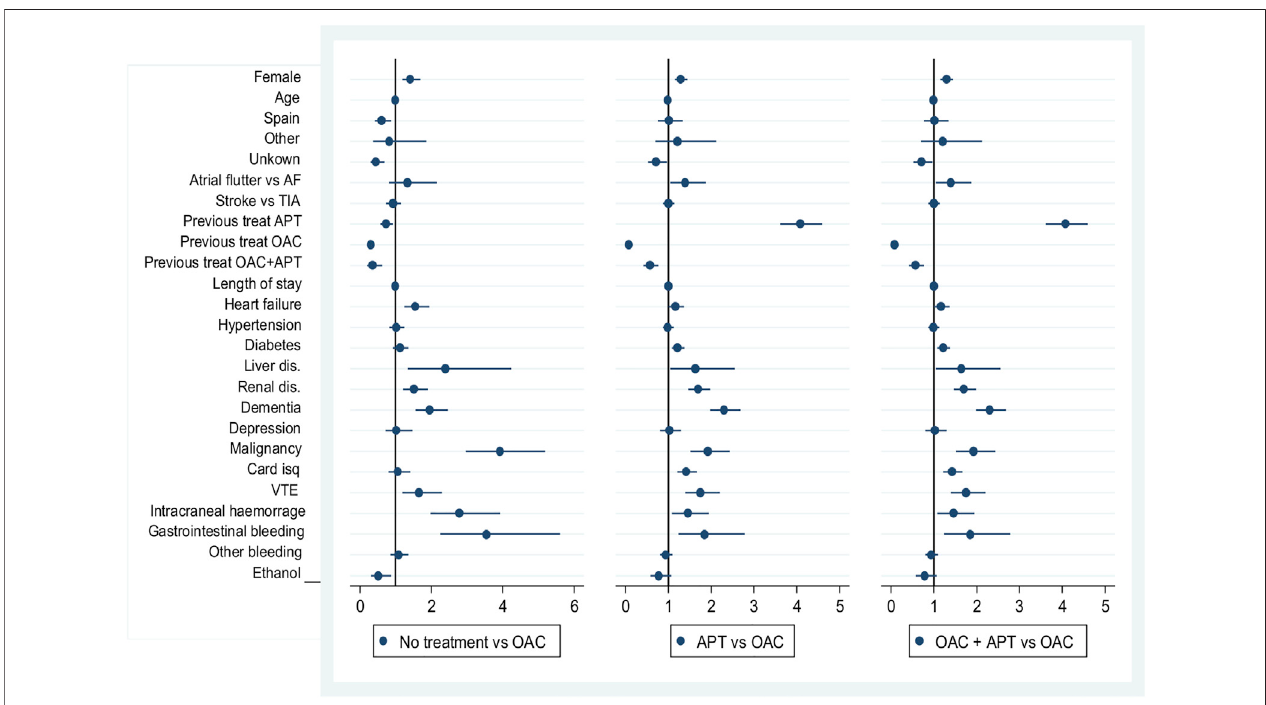
FIGURE 3 | Predictors of treatment strategies in stroke survivors with atrial fi